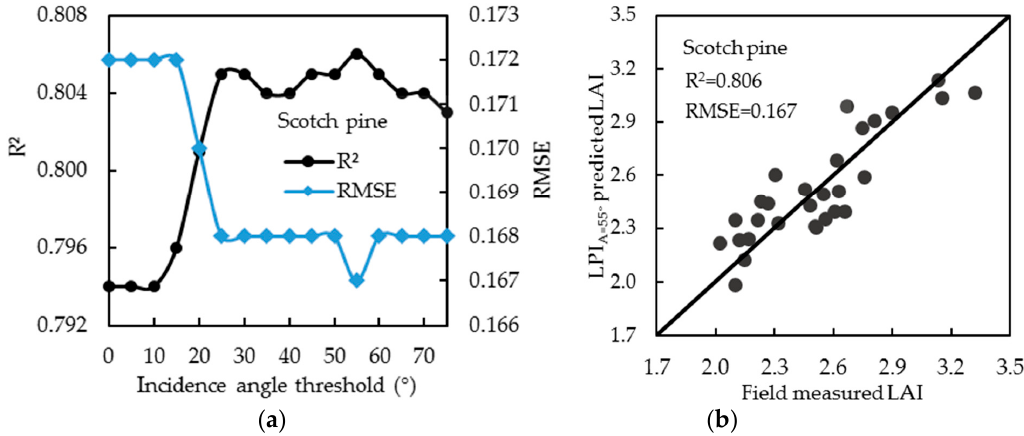
Figure 6. The LAI estimation results for Scotch pine forests with incidence angle normalisation: ( a ) LAI estimation accuracy with different incidence angles; ( b ) The relationship between the field-measured LAI and LiDAR-predicted LAI when incidence angle threshold was set to 55° (i.e., LPI A = 55° ). R 2 and RMSE are values from leave-one-out cross-validation.